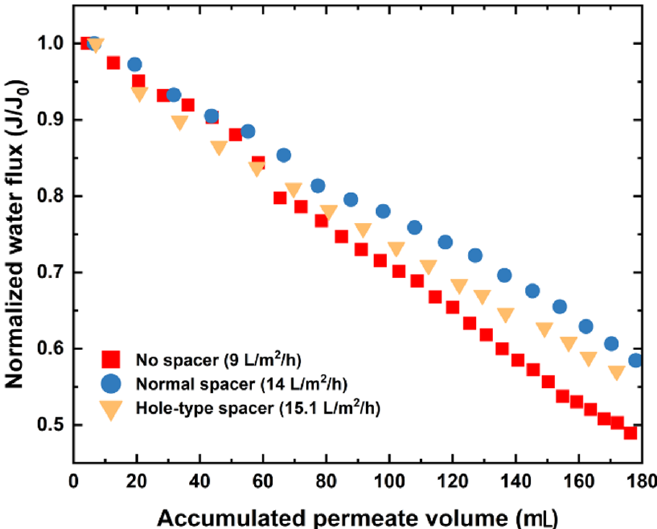
Figure 4. Normalized water flux as a function of accumulated permeate volume, NaCl (5 M) is used as DS for all experiments.